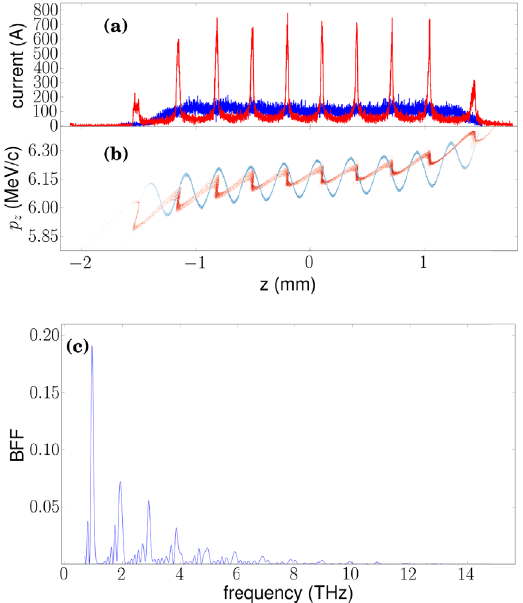
FIG. 6. Current profiles (a) and associated longitudinal phase spaces (LPS) (b) simulated at the exit of the DLW (blue trace) and at the location of maximum bunching (red trace) z ¼ 1 . 3 m from the photocathode. Bunch form factor (BFF) (c) obtained at z ¼ 1 . 3 m from the photocathode. The simulations correspond to the parameters listed under the S-band column in Table